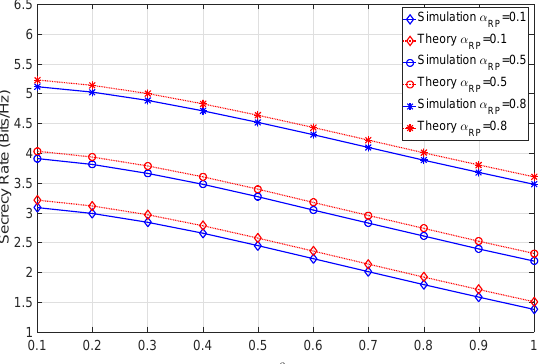
Figure 13. Secrecy rate of the system for various ray power ratios with β N = 100 and β M = 10 at 12 dB